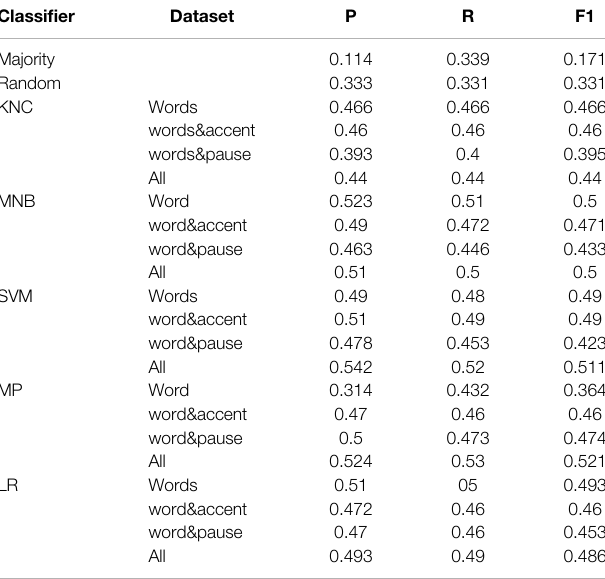
TABLE 6 | Results of classi fi ers predicting pronominal type in NOMCO